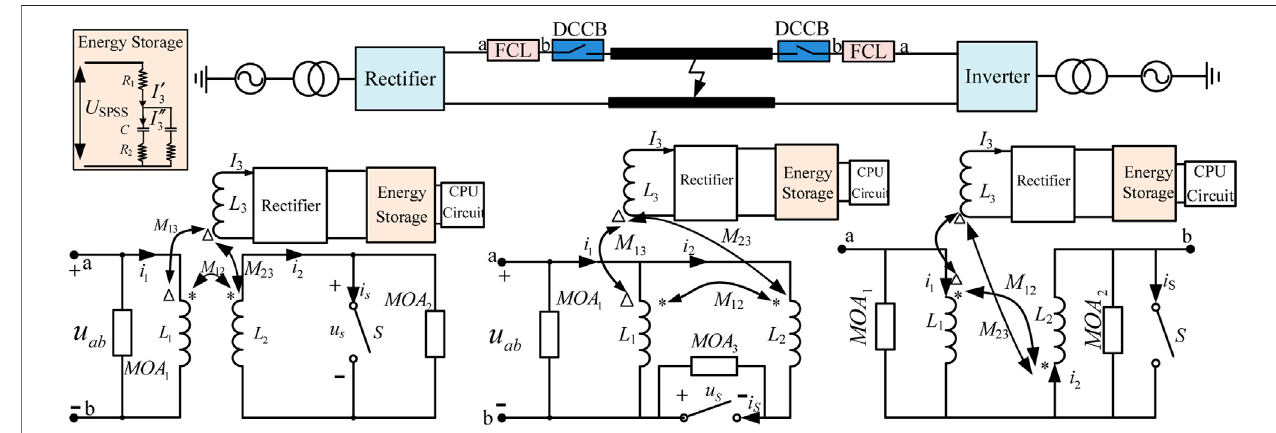
FIGURE 6 | DC grid with the DCCB and SSFCLs.